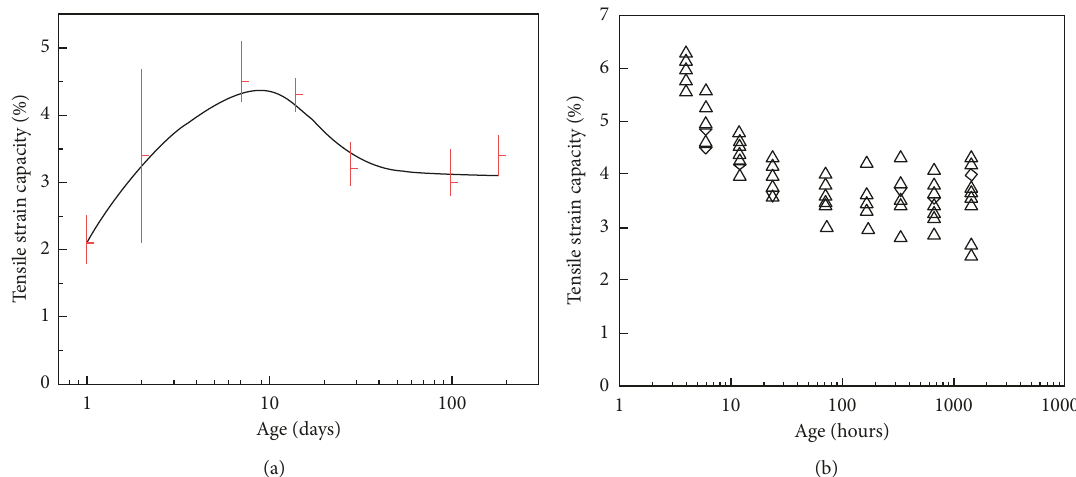
Figure 1: Tensile strain capacity of the highly ductile cement-based fiber-reinforced composite with time: (a) Wang and Li [21]; (b) Li and Li [20].